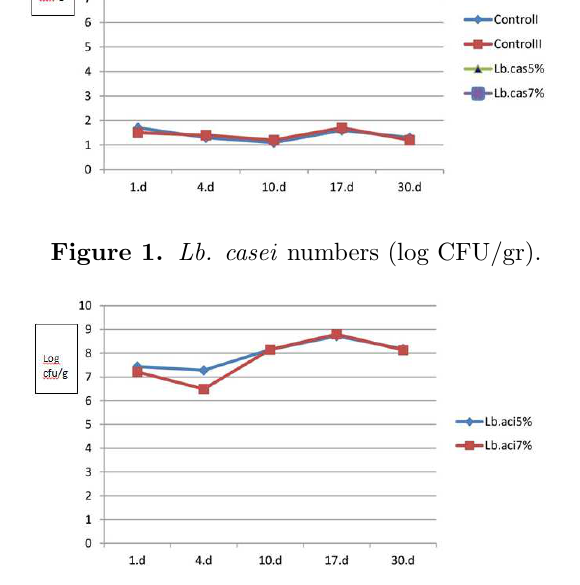
Figure 2. Lb. acidophilus numbers (log CFU/gr).